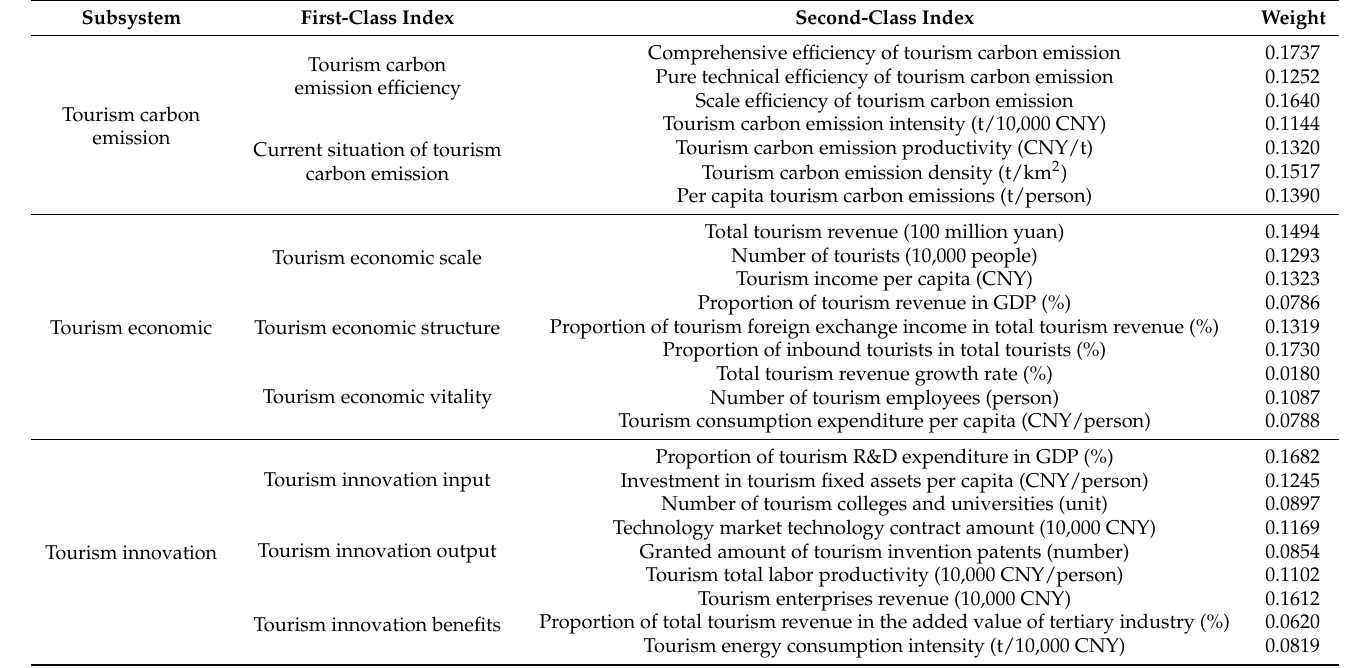
Table 2. The comprehensive evaluation indexes of three